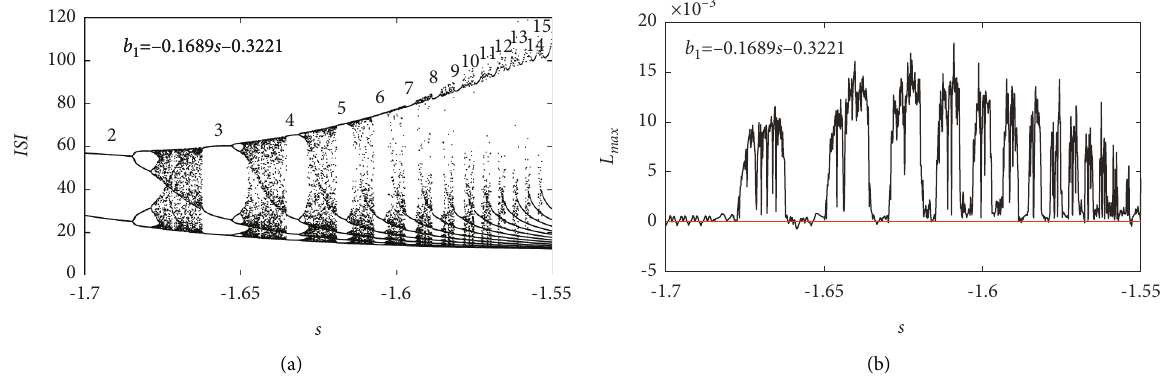
Figure 3: Bifurcation diagram (a) and the largest Lyapunov exponent diagram (b) along the black line ( b s ∈ [− 1 . 7 , − 1 . 55 ] ) in Figure 1(a).